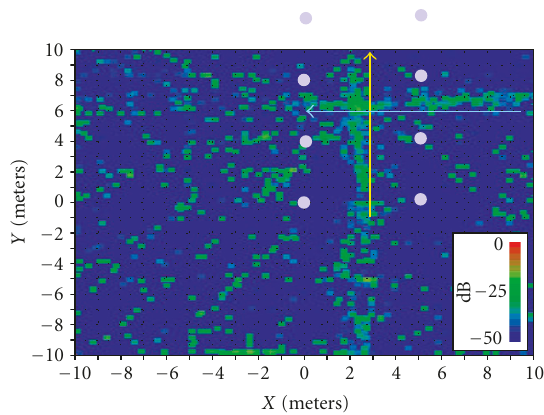
Figure 15: Energy map for a recording of our moving speaker sce- nario. The arrows depict the trajectory of the two speakers. Energy is integrated over the entire duration of the input audio sequence. Note how the two intersecting trajectories are clearly reconstructed.